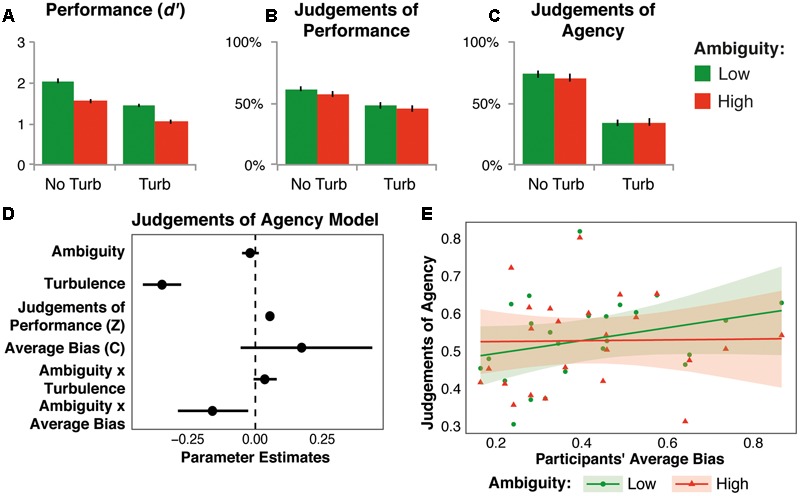
Results of Experiment 2. Effects of ambiguity and turbulence on mean d’
(A), JoPs (B), and JoAs (C). No Turb, no turbulence; Turb, turbulence. Error bars show the standard error of the mean. (D) Parameter estimates, with bootstrapped 95% confidence intervals, for modeling JoAs by the independent variables, JoPs (Z-score, within participants), and average bias (centered, between participants). (E) Average JoAs across participants (points) and model predictions (regression line, and shaded 95% prediction intervals) for the relation between the effect of stimulus ambiguity on JoAs and participants’ average response bias. Participants with a larger bias had a more conservative response criterion. Predictions were obtained from 10,000 simulations from the posterior distribution of plausible parameter values under uniform priors (Gelman and Su, 2015).